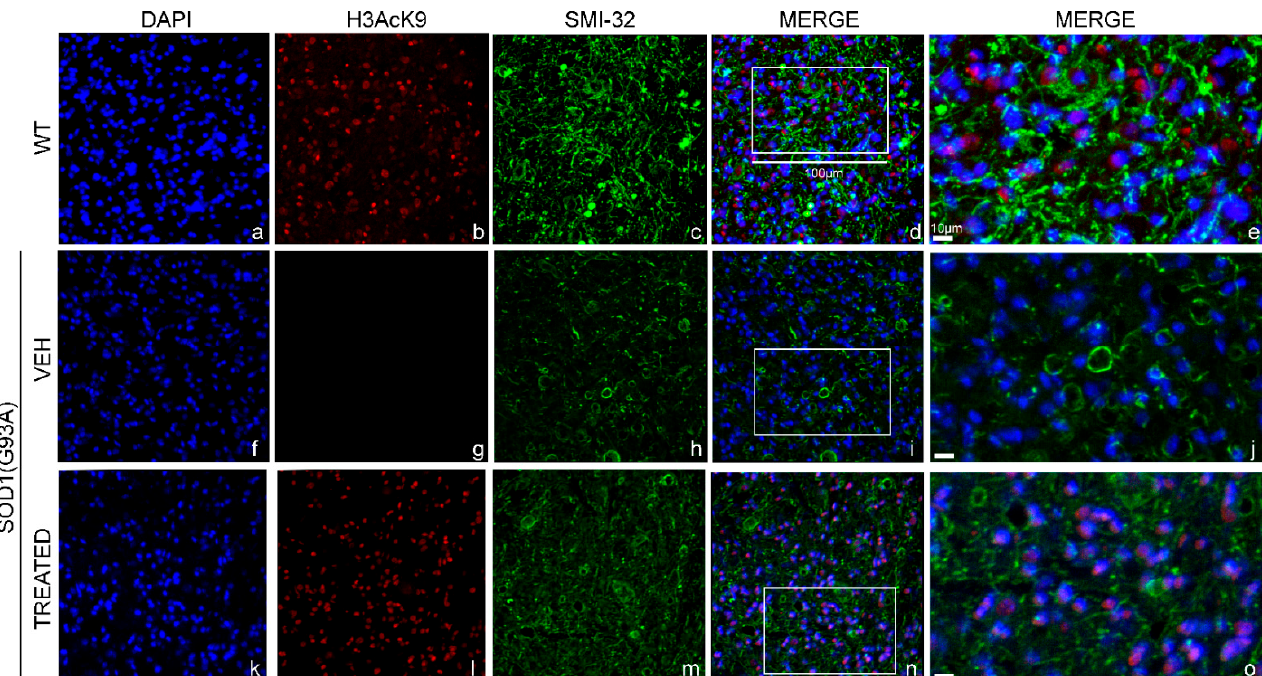
Figure 8. Histone 3 acetylation in the lumbar spinal cord of male WT and SOD1(G93A) mice: The figure panel shows the different acetylation states of lysine 9 of histone 3 in the lumbar spinal cord of wild type (WT) mice, VEH and TREATED SOD1(G93A) groups. The nuclei were stained in blue with DAPI ( a , f , k ). The acetylation state of histone 3 was identified by the H3AcK9 antibody in red ( b , g , l ), while the motor neurons (MN) was detected by identifying the antibody neurofilament H with the SMI-32 antibody in green ( c , h , m ). The acetylation state of histone 3 was drastically reduced in the VEH group ( g ) compared to WT animals ( b ). The treatment with RESV and VPA led to a restoration of the acetylation of histone 3 in the TREATED group ( l ), (n = 3 WT, 5 VEH, 6 TREATED). Figure ( d , i , n ) shows the superimposed images of DAPI, SMI-32 and H3AcK9 in the WT, VEH and TREATED groups, respectively. Magnification of 20×, scale bar = 100 μ m ( a – d , f – i , k – n ). The figure panel ( e , j , o ) shows the highlighted area in ( d , i , n ) at a higher magnification of 40×, scale bar = 10 μ m.